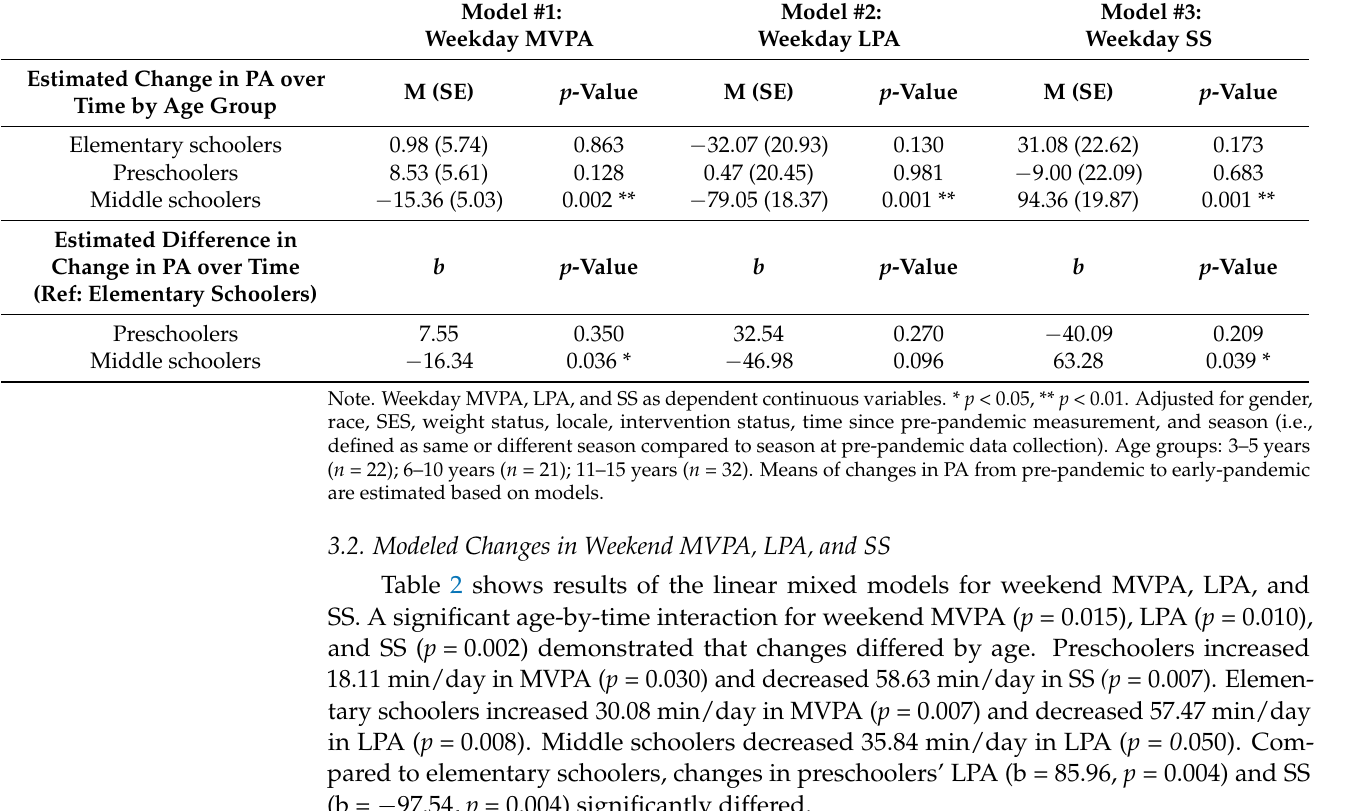
Table 1. Results of mixed model analyses for weekday MVPA, LPA, and SS ( n = 74). Model #1: